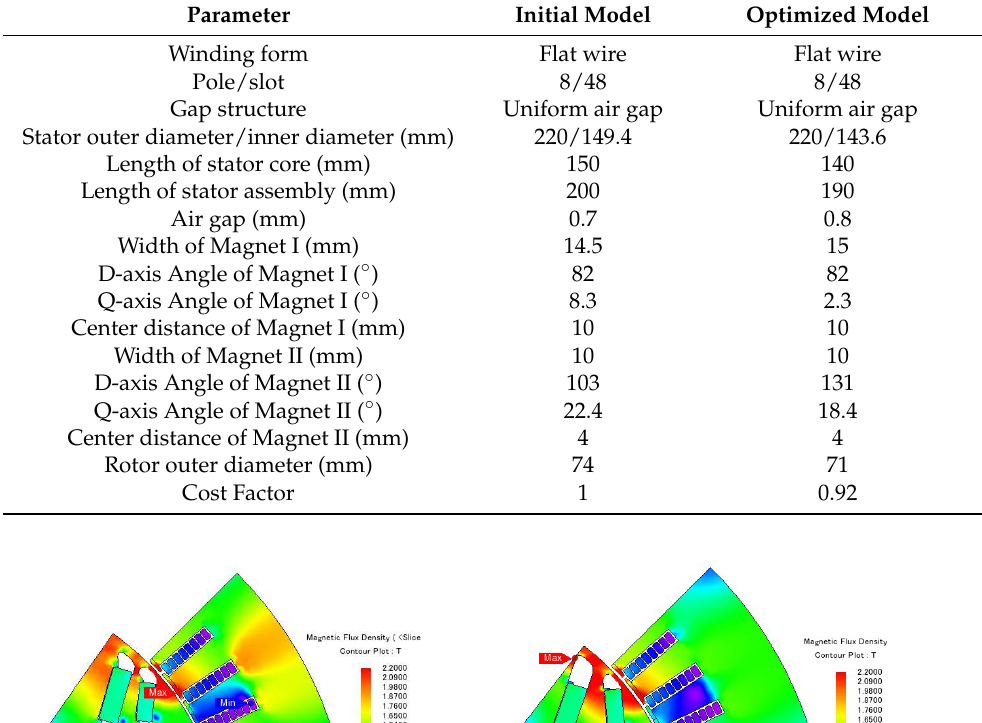
Table 6. Comparison of design parameters.